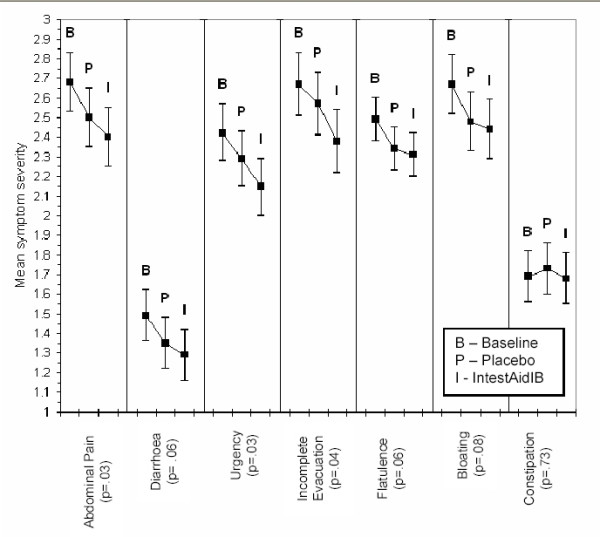
mean symptom severity ratings with 95% C.Is.